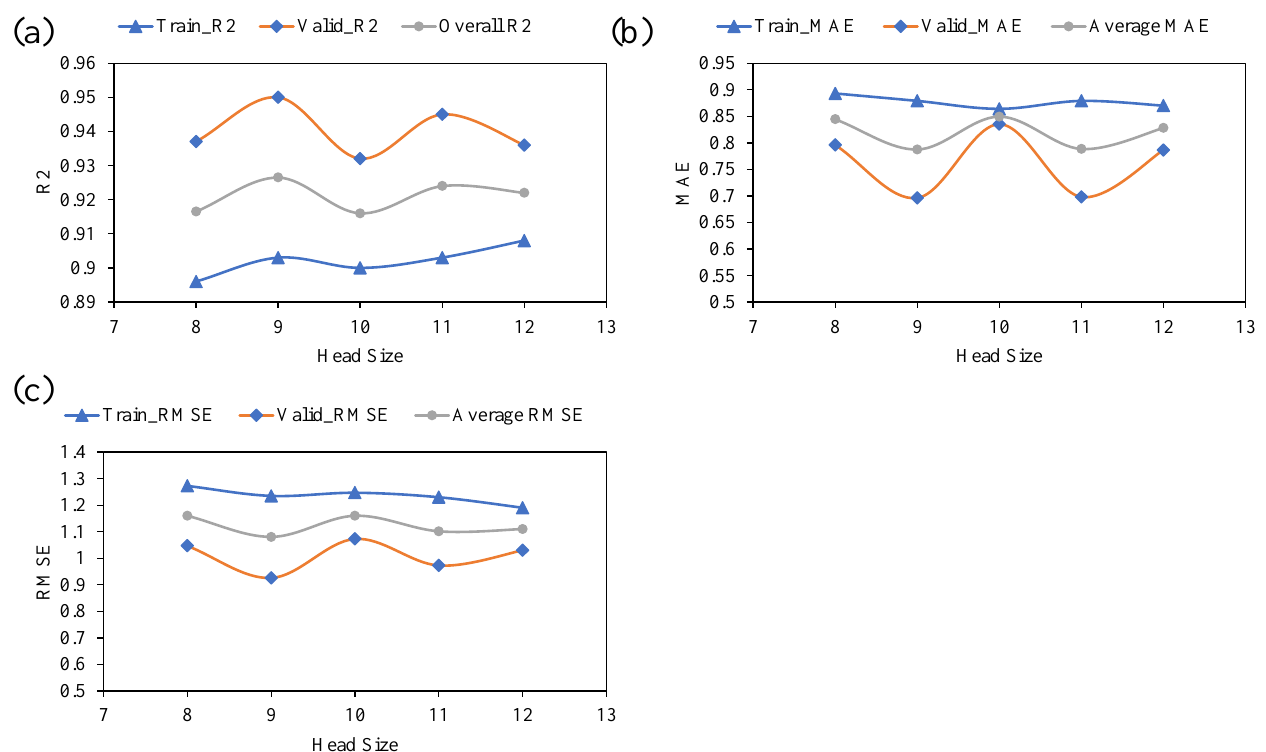
Figure 6. Effect of head size on the performance of the models: ( a ) R 2 , ( b ) MAE, and ( c ) RMSE.